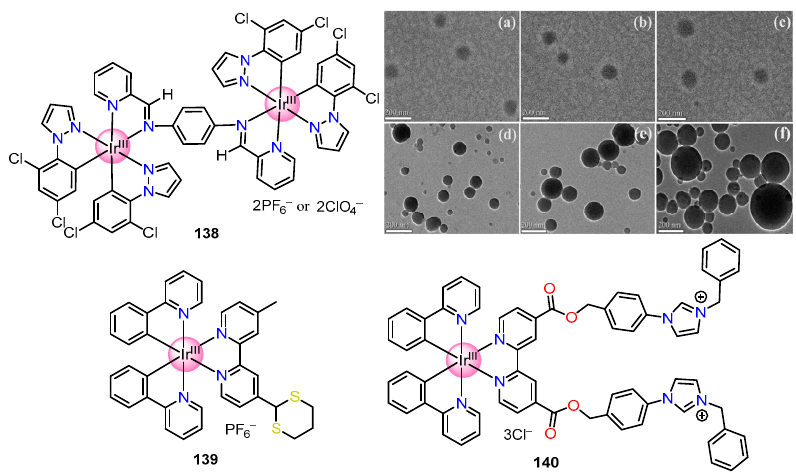
Figure 20. Structures of Ir(III) complexes 138 – 140 and TEM images of nanoparticles found from anion titration of ( a ) Free 138 ( b ) 138 + 10 equiv. HPO 42 − ; ( c ) 138 + 10 equiv. I − ; ( d ) 138 + 3 equiv. ClO 4 − ; ( e ) 138 + 5 equiv. ClO 4 − ; ( f ) 138 + 10 equiv. ClO 4 − . [Adapted from reference [145]; Copyright © 2023, Royal Society of Chemistry]